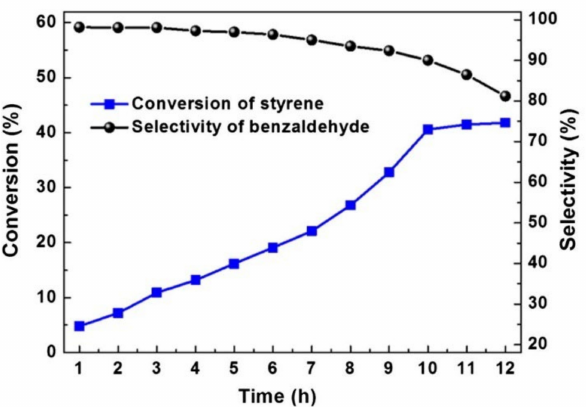
Figure 20. Selective oxidation of styrene to benzaldehyde by hydrogen peroxide, catalyzed by Co 3 O 4 @-HZSM-5. Adapted with permission from Reference [144]. Copyright (2018) Elsevier Inc. (Amsterdam, The